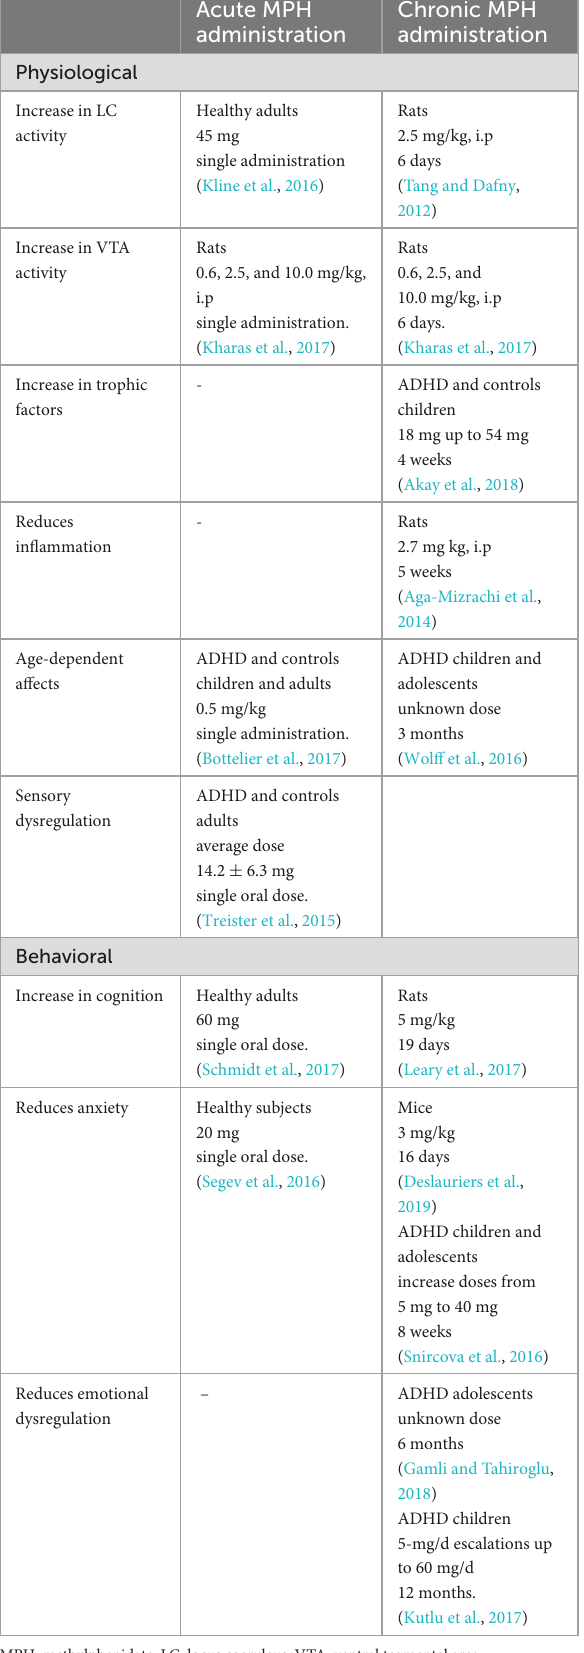
TABLE 1 A comparison of the effects of acute or chronic methylphenidate administration. Acute MPH